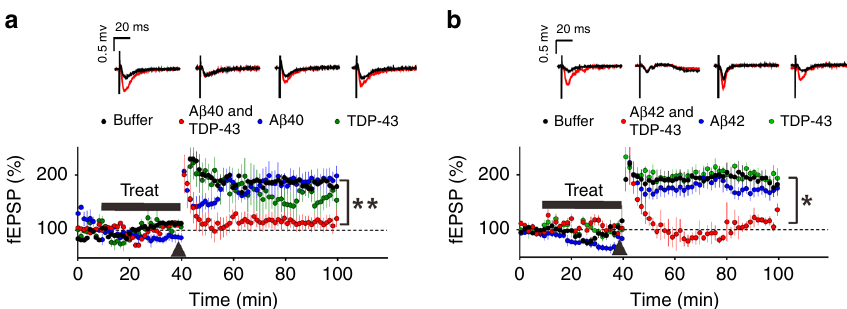
Fig. 4 TDP-43-induced A β species impairs the hippocampus LTP. Field EPSPs (fEPSPs) were measured from a Schaffer collateral fi ber on a hippocampal slice from C57BL/6 mice. After the recording was stabilized for 10 min, the slices were treated with buffer, A β with TDP-43, A β alone, or TDP-43 alone for 30 min. After the treatment, the hippocampal slices were subjected to a theta burst stimulation (black arrowhead) to induce LTP. Scale bar, 0.5 mv, 20 ms. The averaged data and s.e.m. are plotted and colored for buffer control (black), A β and TDP-43 (red), A β (blue), and TDP-43 (green). Each group of fEPSPs before (black line) and after (red line) the theta burst stimulation is shown individually in the upper panel. a For A β 40 analysis, A β 40 at 1 µ M and TDP-43 at 10 nM were used. The slices were treated with buffer ( n = 4 independent slices), A β 40 with TDP-43 ( n = 3, independent slices), A β 40 alone ( n = 4, independent slices), or TDP-43 alone ( n = 4, independent slices). TDP-43 + A β 40 vs. buffer; repeated two-way ANOVA, p = 0.0032, ** p < 0.01. b For A β 42 analysis, A β 42 at 62.5 nM and TDP-43 at 0.625 nM were used. The slices were treated with buffer ( n = 9 independent slices), A β 42 with TDP-43 ( n = 4, independent slices), A β 42 alone ( n = 5, independent slices), or TDP-43 alone ( n = 5, independent slices). TDP-43 + A β 42 vs. buffer; repeated two- way ANOVA, p = 0.0232, * p < 0.05. Source data are provided as a Source Data fi le.